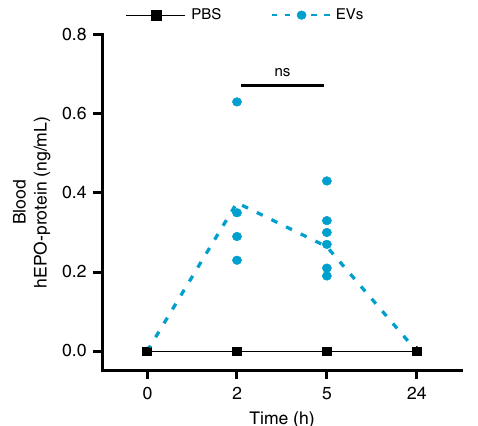
Fig. 3 Detection of hEPO protein in mouse blood after hEPO mRNA delivery via EVs Mice were intravenously injected with 100 μ L of mc3-EVs containing 1.5 µ g of hEPO mRNA (per mouse). The concentrations of hEPO protein in murine plasma were determined by Gyros immunoassay for hEPO at 0 (untreated), 2, 5, and 24 h after EV injection. The hEPO protein was detected in mouse blood at 2 h after EV injection. N = 8 independent animals at each time point except for 2 h ( n = 4) are presented. The plasma hEPO protein from mc3-EV delivery was compared between 2 and 5 h by unpaired two-tailed Student ’ s t -test, although the difference was not statistically signi fi cant (ns = not signi fi cant). Source data are provided as